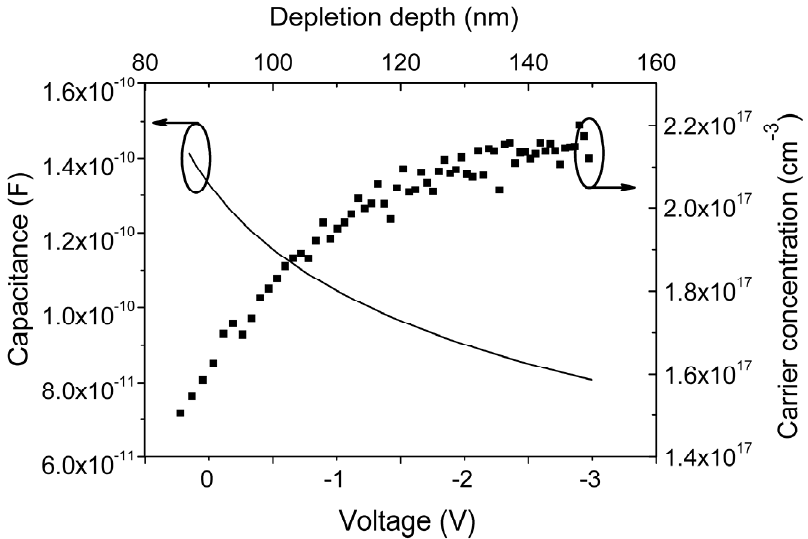
Figure 3. C–V characteristics of the Pd / ZnO SBDs as a function of reverse bias at 1 MHz. Carrier concentration versus depletion width is also plotted. Table 2. The extracted parameters of the Pd / ZnO SBDs at room temperature: the ideality factor